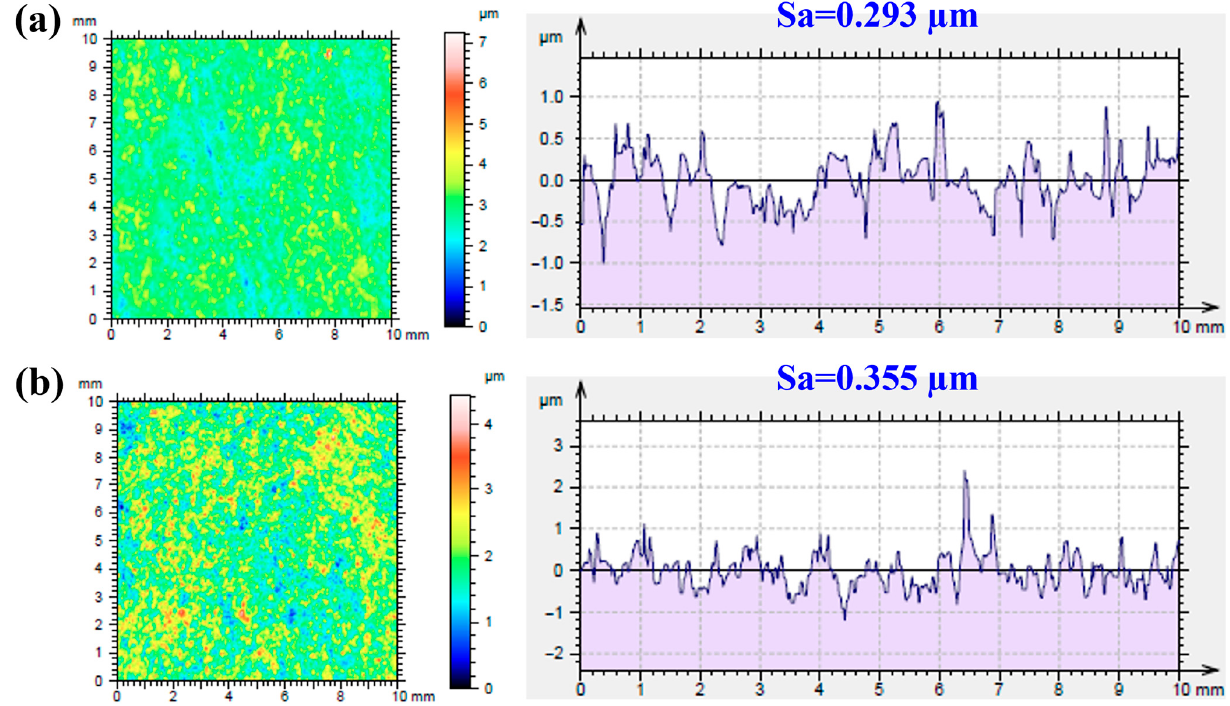
Figure 2. Roughness average of ( a ) the MAO and ( b ) the MAOCa coated ZK60 samples.